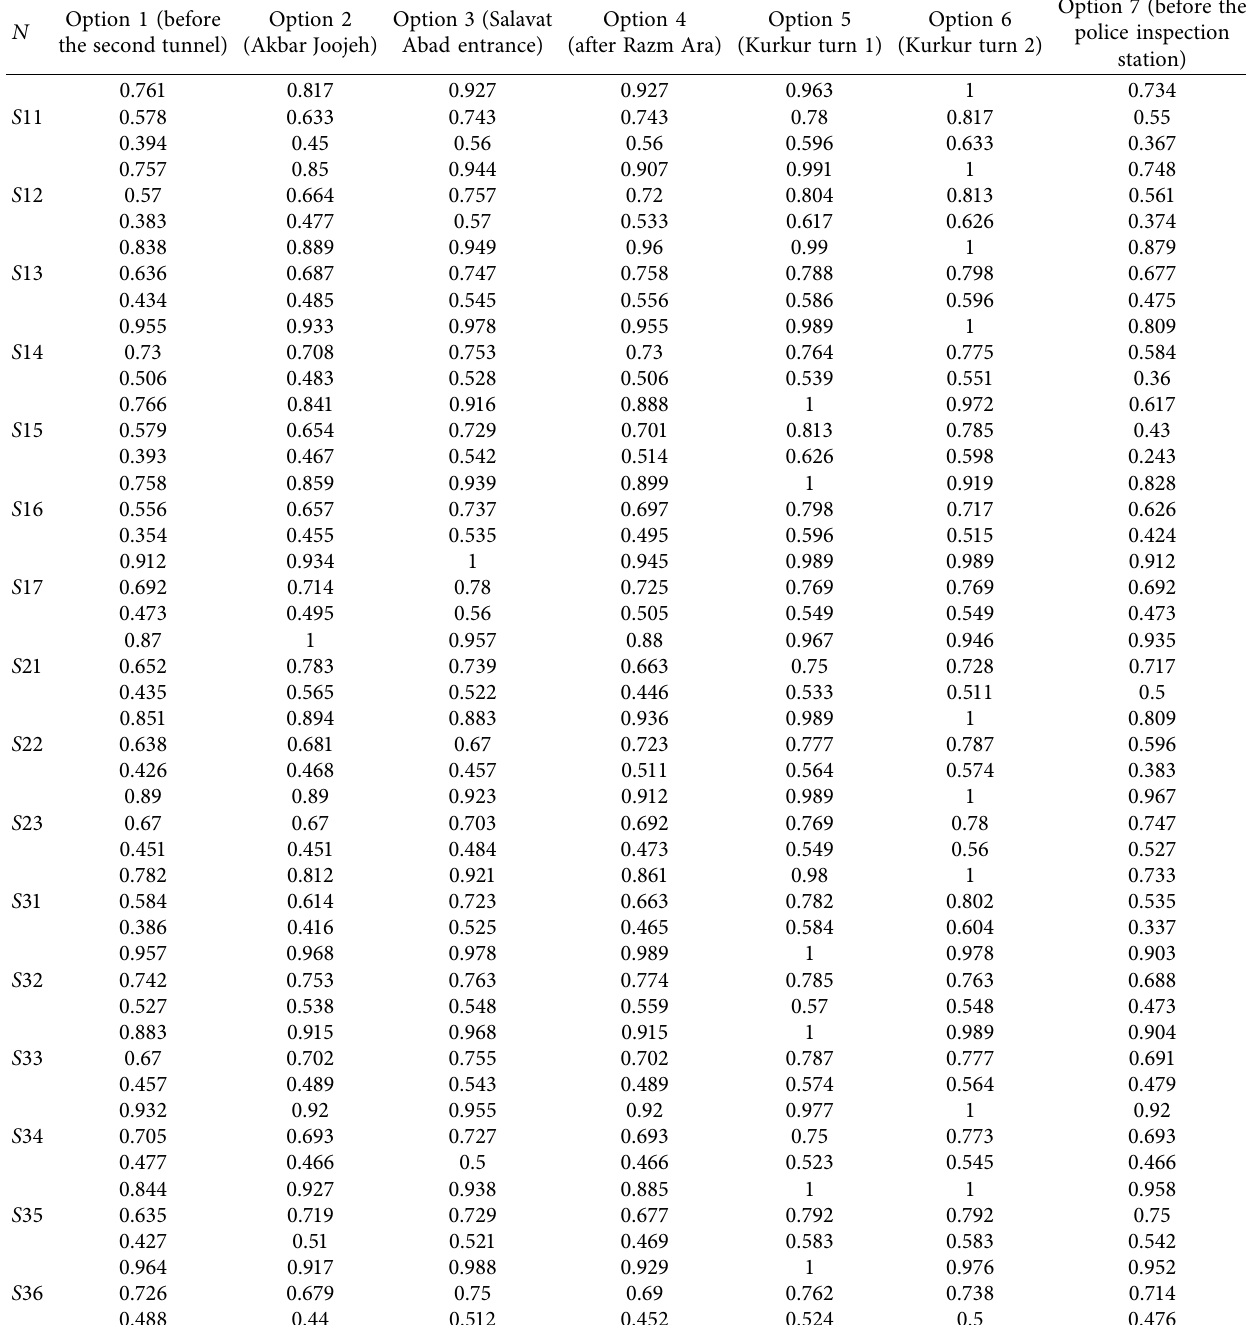
Table 13: Unscaled decision matrix N